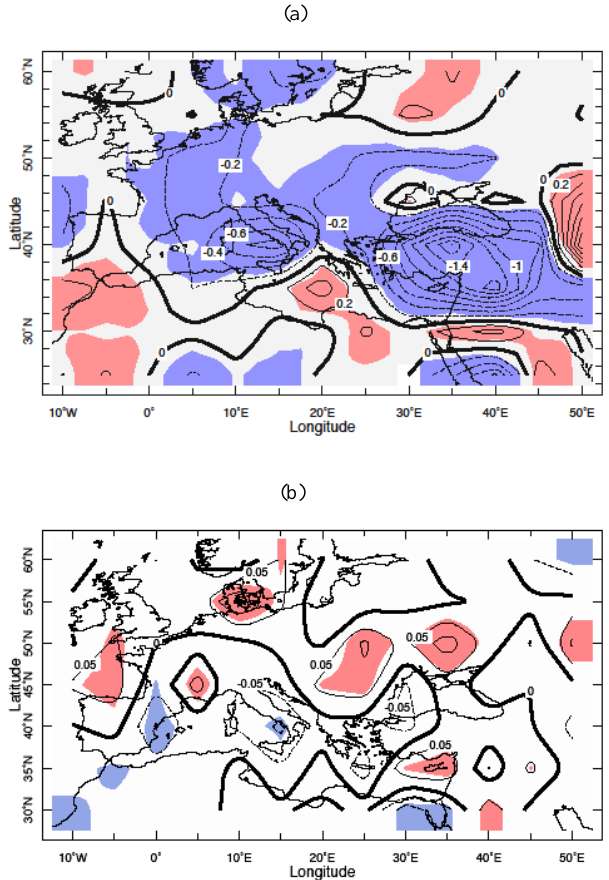
Fig. 4. Long-term trend in cyclone counts for DJF (in units of per- centage per 10yr) of (a) observations and (b) average of the 9 study models. The sign and significance of the trend is represented as in Fig.